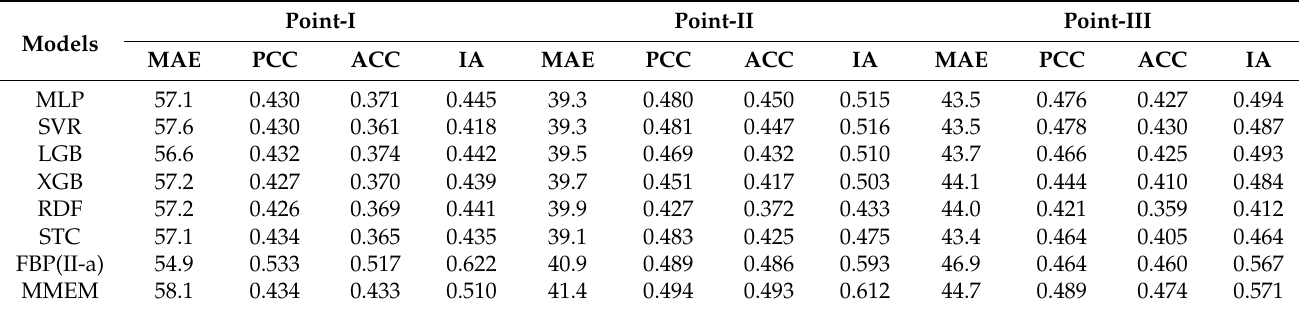
Figure 4. Monthly rainfall predicted from different regression models. Table 3. Skills comparison of different regression